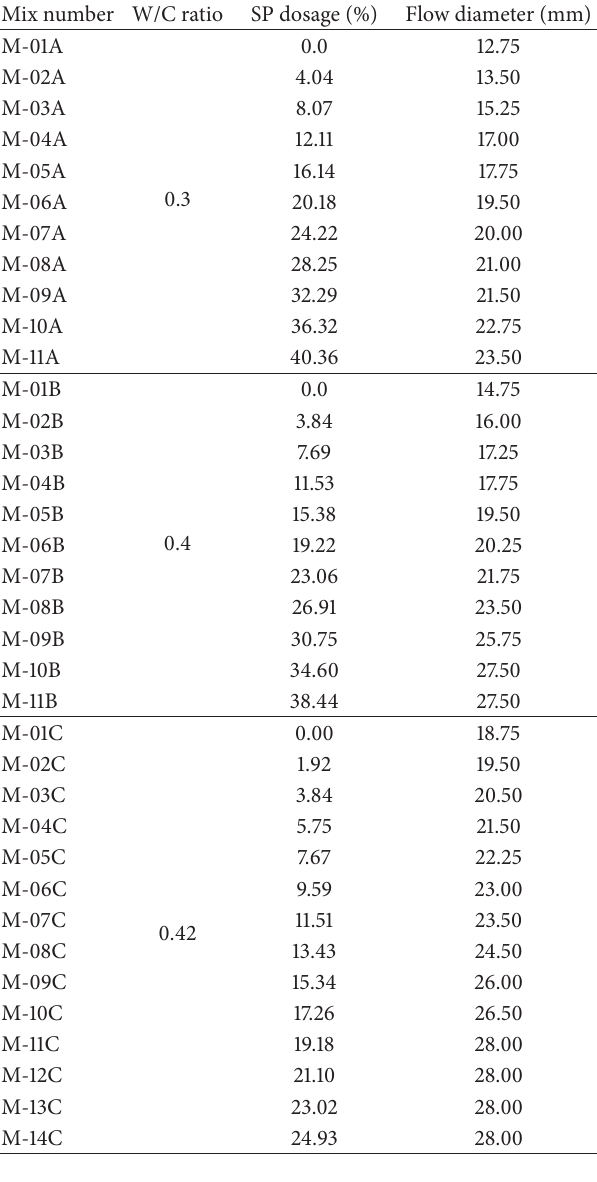
Table 3: Compatibility test results.